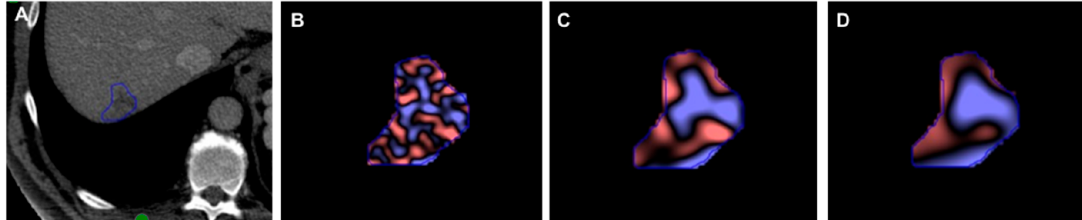
Figure 3. Representative single-slice images at the level of the largest diameter of the LIRADS 5 lesion in the arterial phase were identified and then sent to a commercially available texture analysis research software platform; then, texture features were extracted using commercially available research software. Using the software, a region of interest (ROI) was manually drawn on a single slice corresponding to the largest diameter of the lesion in the arterial phase for RPHCC ( A ) for ( B ) fine, ( C ) medium, and ( D ) coarse filters.